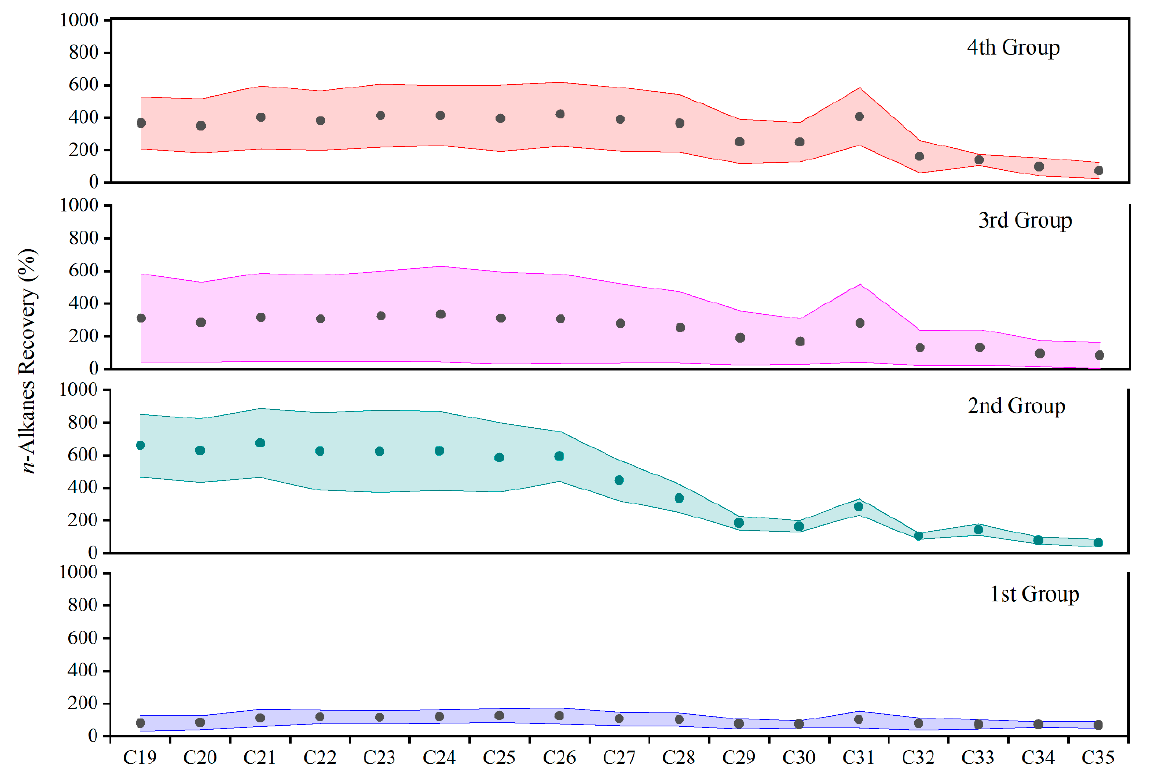
Figure 2. The recoveries of 17 n − alkanes with ASE pretreatment under the different experimental parameters (shading represents the upper and lower errors).